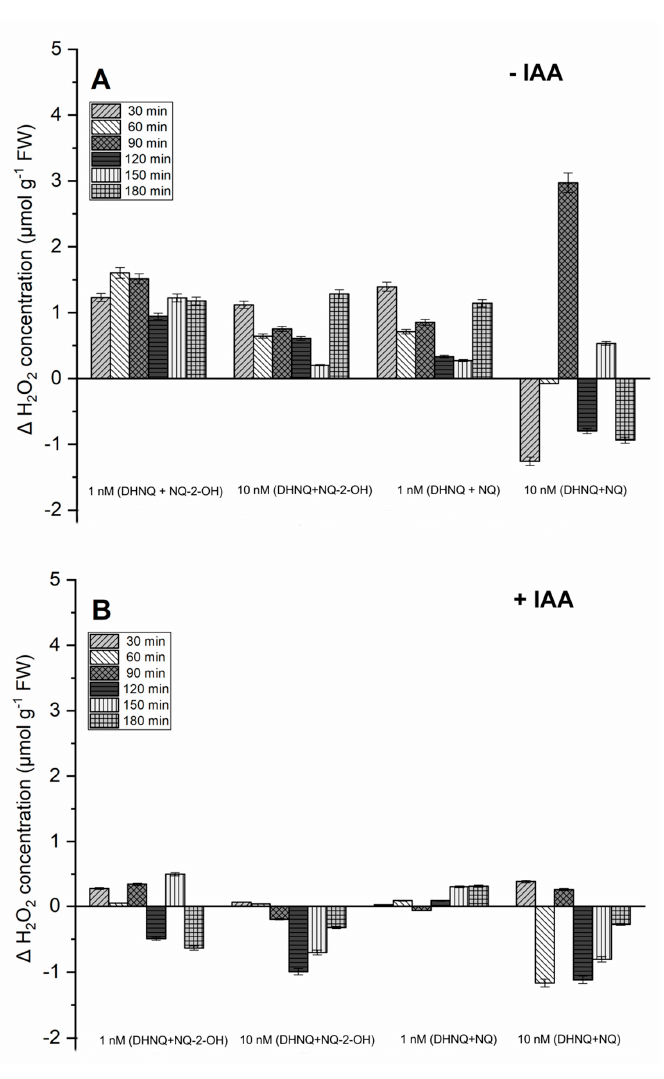
Figure 4. The effect of DHNQ combined with NQ-2-OH or NQ on hydrogen peroxide production in the maize coleoptile segments that had been incubated ( A ) without and ( B ) with IAA. The presented data is the mean of six independent experiments (delta received by the subtraction of the control value from the tested value). Bars indicate the means ± SEs.